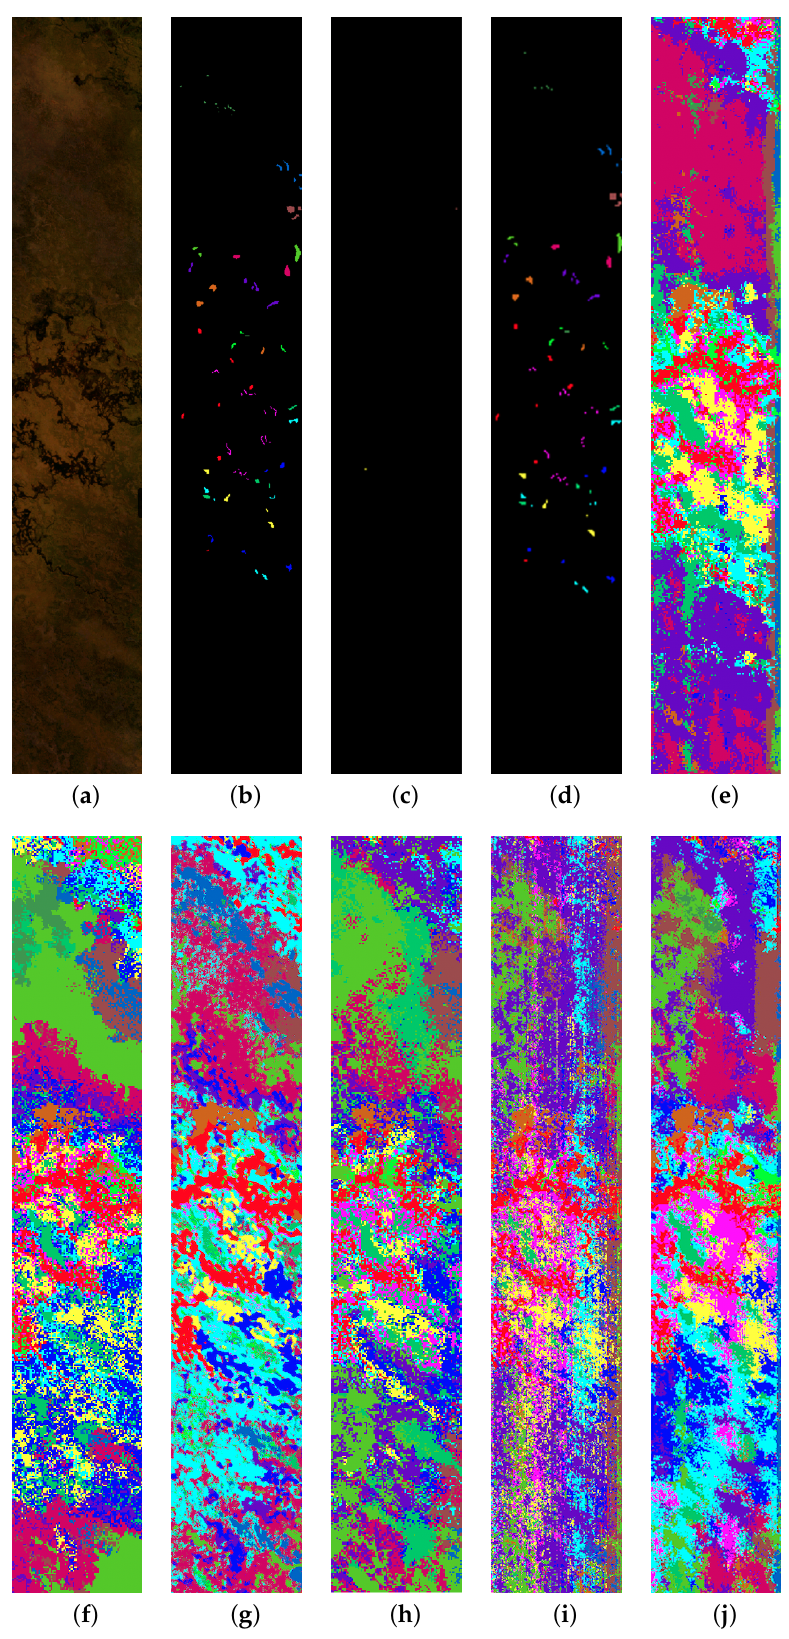
Figure 9. Classification maps of different methods on the Botswana data set. ( a ) False Colour Image; ( b ) Ground Truth; ( c ) Training set; ( d ) Test set; ( e ) LCMR; ( f ) SCMK; ( g ) CEGCN; ( h ) PRNet; ( i ) LCEM; ( j )